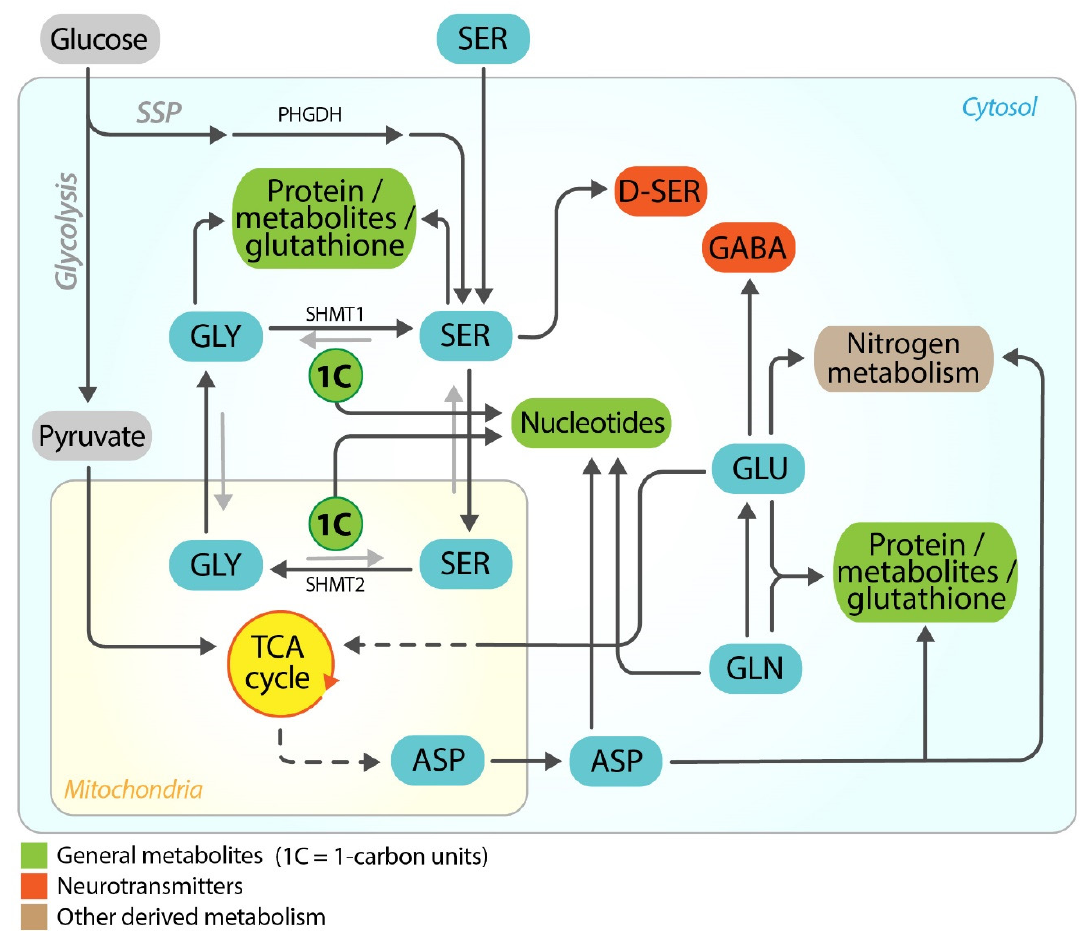
Figure 1. General metabolism of serine, glycine, glutamate, and glutamine. Overview of the possible metabolic pathways relevant to anabolism, redox and nitrogen homeostasis, and energy production. Metabolites specific to the brain, relevant to this review, are also included in red. For clarity, only two enzymes are reported: phosphoglycerate dehydrogenase (PHGDH), responsible for the serine synthesis pathway (SSP), a branch of glycolysis and serine hydroxymethyltransferase (SHMT), responsible for the reversible conversion of serine and tetrahydrofolate (THF) into glycine and 5,10-methylene-THF; SHMT isoforms are present in mitochondria (SHMT2) and cytosol (SHMT1), respectively. These enzymes fuel one carbon metabolism (1C in the figure), which is closely connected to the folate and methionine cycles. Glutamine also contributes to the production of purines, pyrimidines and amino sugars, as well as of nicotinamide adenine dinucleotide phosphate (NADPH, not shown) [28,29], which, in turn, is used to maintain glutathione in its reduced state, thus keeping oxidative stress under control. As a carbon source, glutamine plays a fundamental role in mitochondrial metabolism, supplying the TCA cycle with anaplerotic carbons, accounting for ATP and macromolecules synthesis. The indications “Protein” refer to protein biosynthesis. Serine-derived metabolites include sphingosine and phosphoserine; glycine-derived metabolites include bile acids, heme and creatine; glutamate-derived metabolites include amino acids and polyglutamylate folates (only most relevant metabolites are listed, not necessarily populated in the same cell).